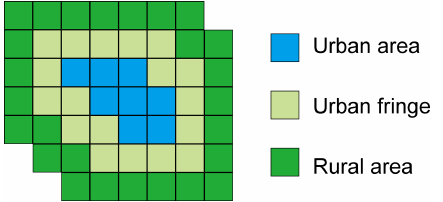
Figure 3. The geographical locations of urban area, urban fringe, and rural